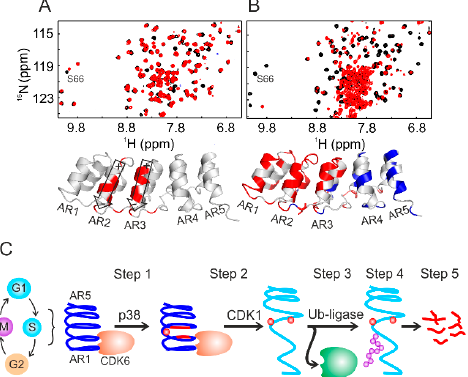
Figure 4. Following cell lysate-induced protein phosphorylation using NMR spectroscopy. (A) Superposition of two-dimensional (2D) 1 H– 15 N HSQC spectra of phosphorylated p19 INK4d at Ser66 (red) and non-phosphorylated protein (black). (B) Superposition of 2D 1 H– 15 N HSQC spectra of doubly phosphorylated p19 INK4d at Ser66 and Ser76 (red) and the non-phosphorylated form (black).